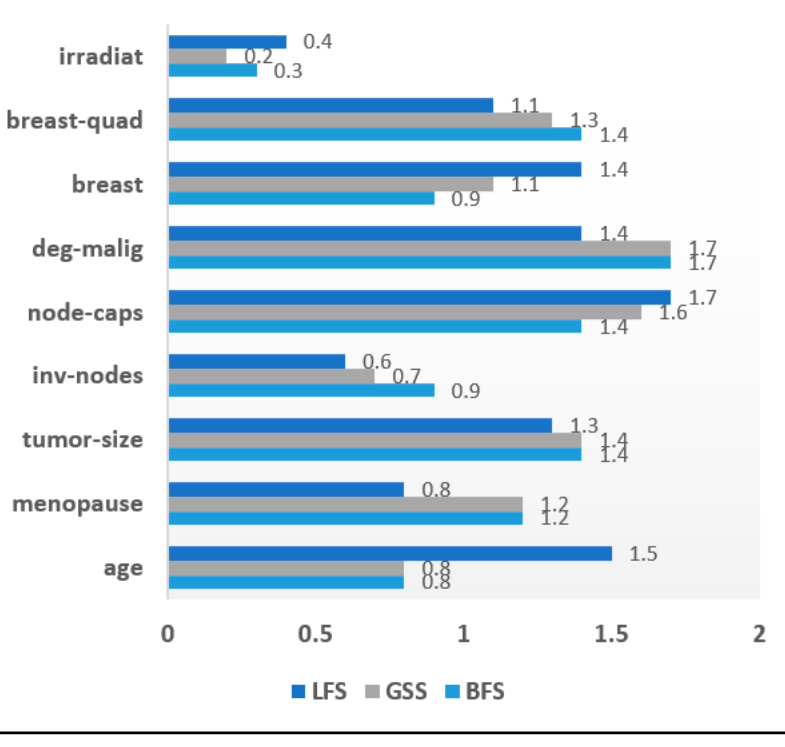
Figure 11. Attribute Significance Graph for the Breast cancer dataset with Wrappers.